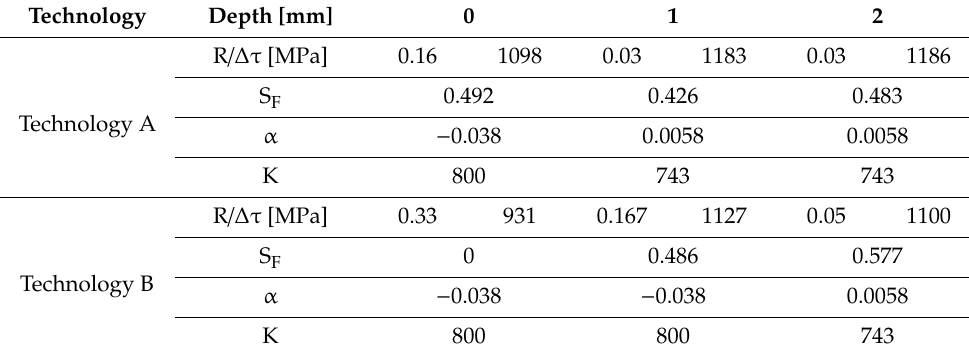
Figure 10. Principal stress components σ 1 and σ 2 during the loading amplitude in dependence of the D-P criterion 0, 1 and 2 mm under the surface of the torsion bar, comparing technologies A and B. Table 4. Safety factor S F , and D-P coe ffi cients α and